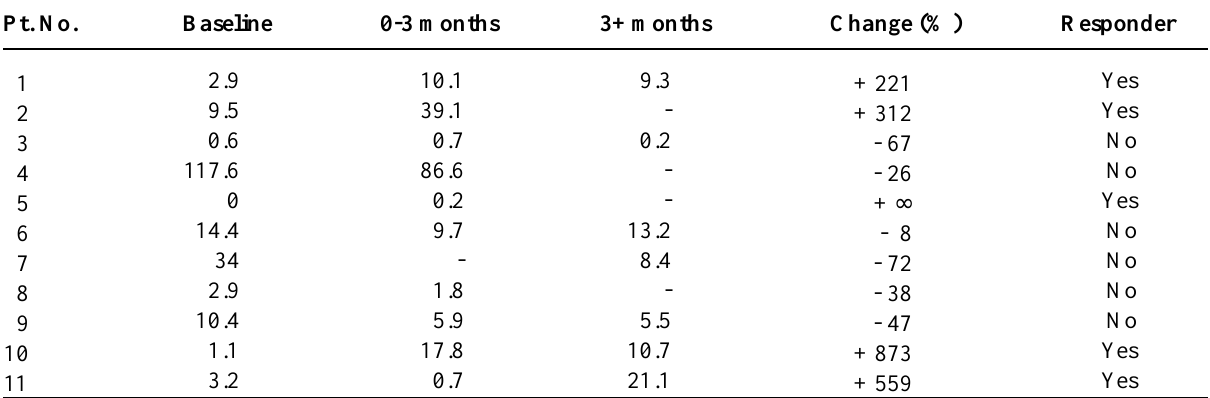
TMC = total motile sperm count, % change: based on last available data compared to baseline for each individual. Response was defined as an increase of TMC ≥